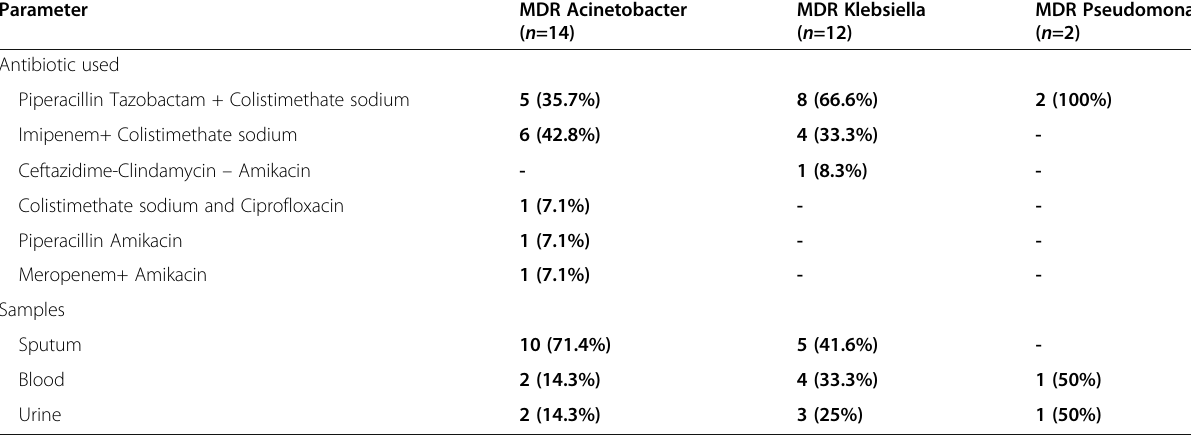
Table 3 Descriptive statistics of each MDR microorganism regarding antibiotic combinations and affected systems